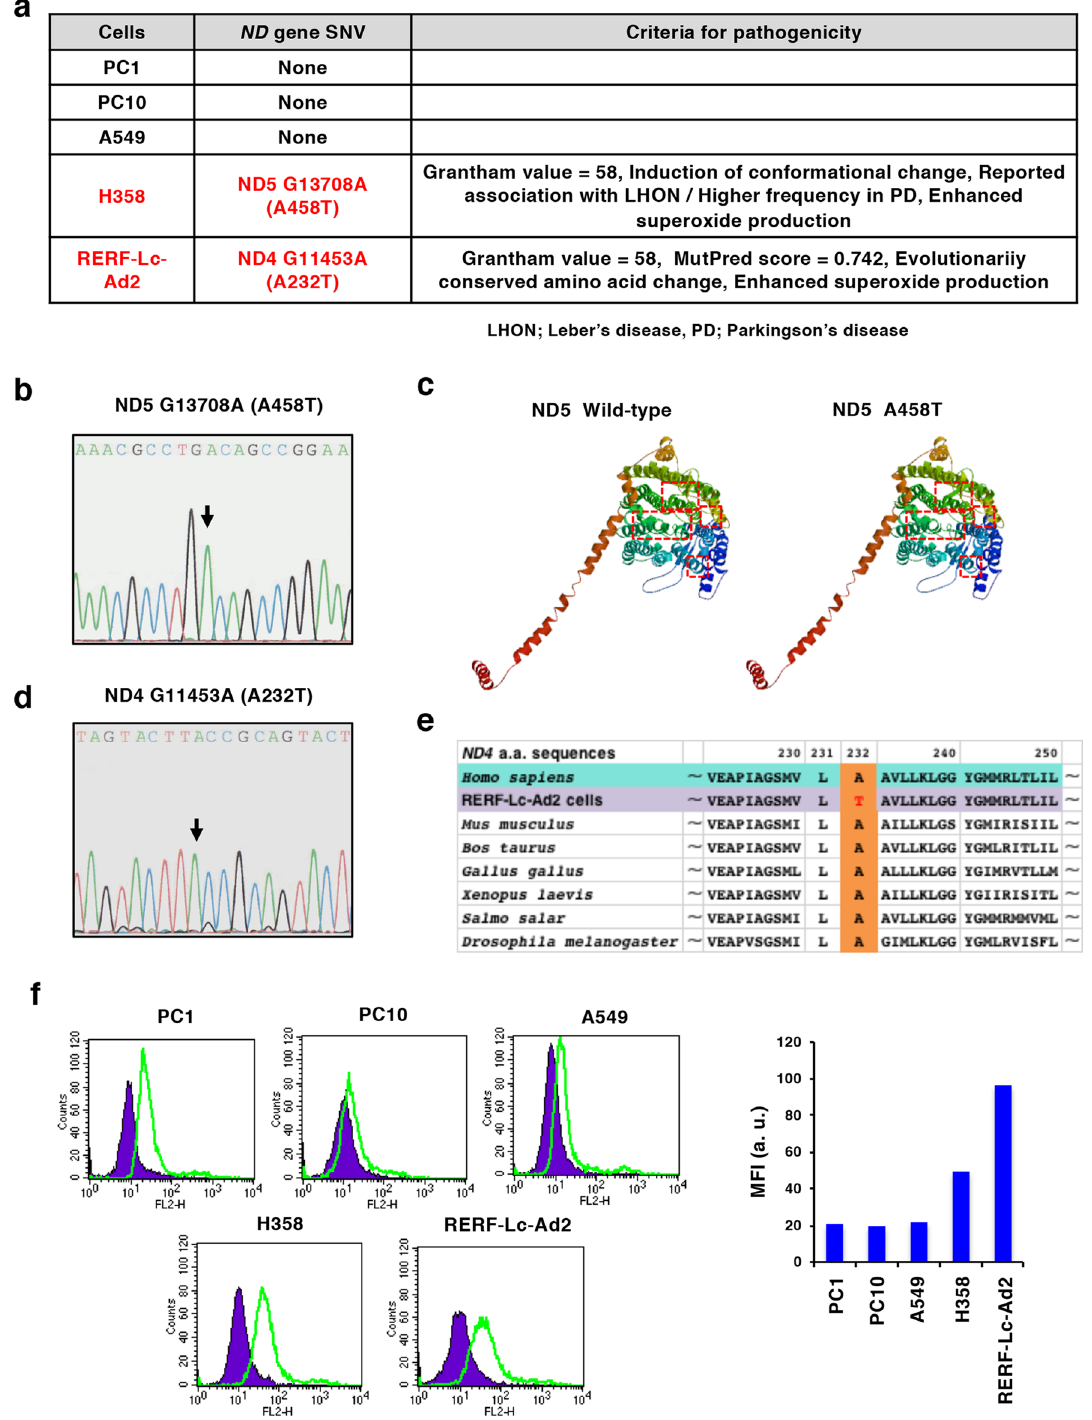
Figure 3. Predicted pathogenic ND mutations found in H358 and RERF-Lc-Ad2 cells. ( a ) Predicted pathogenic SNVs found in NSCLC cells and the criteria for the prediction of pathogenicity. Refer to MITOMAP (https:// www. mitom ap. org/ MITOM AP) for information about disease associations. ( b ) Electropherogram showing the ND5 G13708A (A453T) SNV. ( c ) Conformational change of the protein caused by ND5 G13708A (A453T) SNV, as predicted by SWISS-MODEL (https:// swiss model. expasy. org). Rectangles with a red dashed border indicate the areas containing the conformational change caused by the SNV. ( d ) Electropherogram showing ND4 G11453A (A232T) SNV. ( e ) Evolutionary conservation of the alanine residue. ( f ) Mitochondrial ROS production in NSCLC cell lines. ROS production was examined by MitoSOX-Red staining; mean fluorescence intensity (MFI) were expressed as arbitrary units (a.